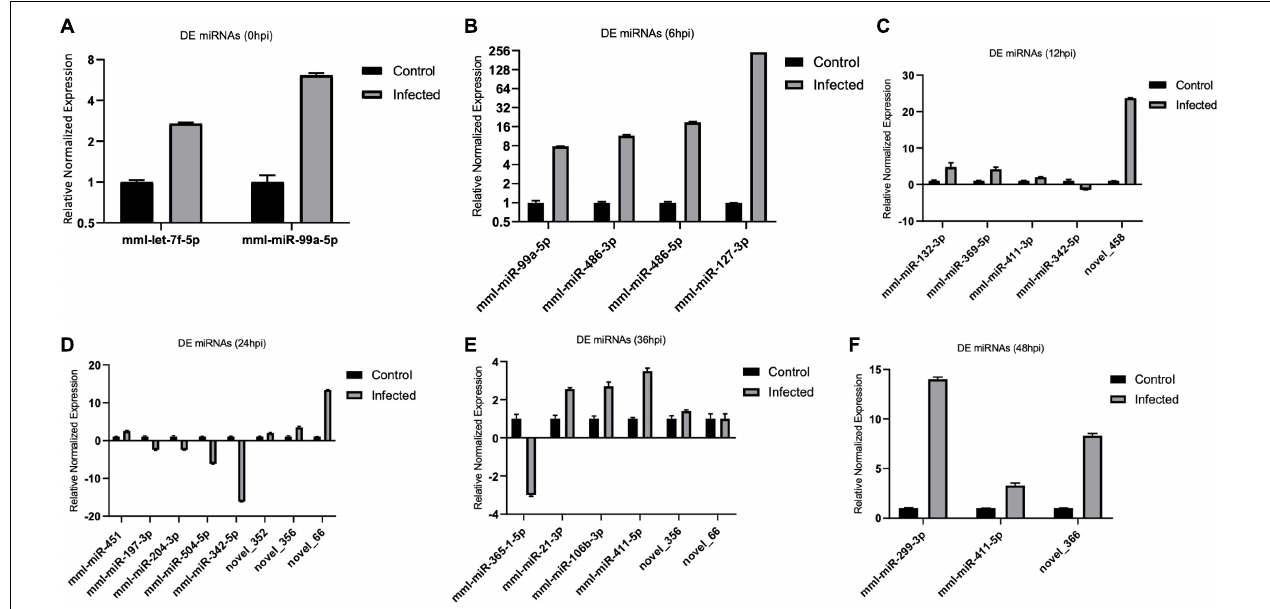
FIGURE 7 | (A–F) Validation of the differentially expressed (DE), microRNAs (miRNAs) by real-time quantitative PCR (qPCR) from 0 to 48 hpi. The differences in expression were determined using the 2 - (cid:49)(cid:49) CT method and with unpaired, two-tailed Student’s t -test for grouped data. All experiments were performed in triplicate ( n = 3). U6 was used as an internal reference. Data represent the mean ± SD ( error bar ). Significant difference thresholds: log2(fold change) > 2 and FDR-adjusted p <